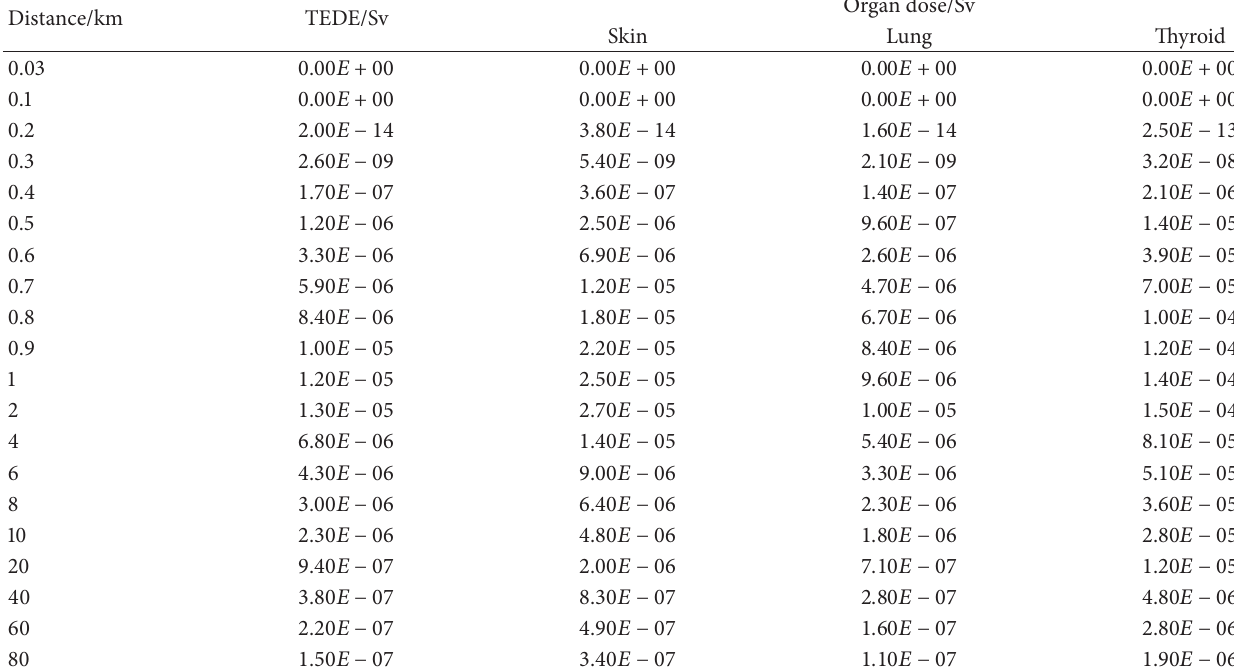
Table 3: Human body dose received in different distance from NPP site in D class ∗